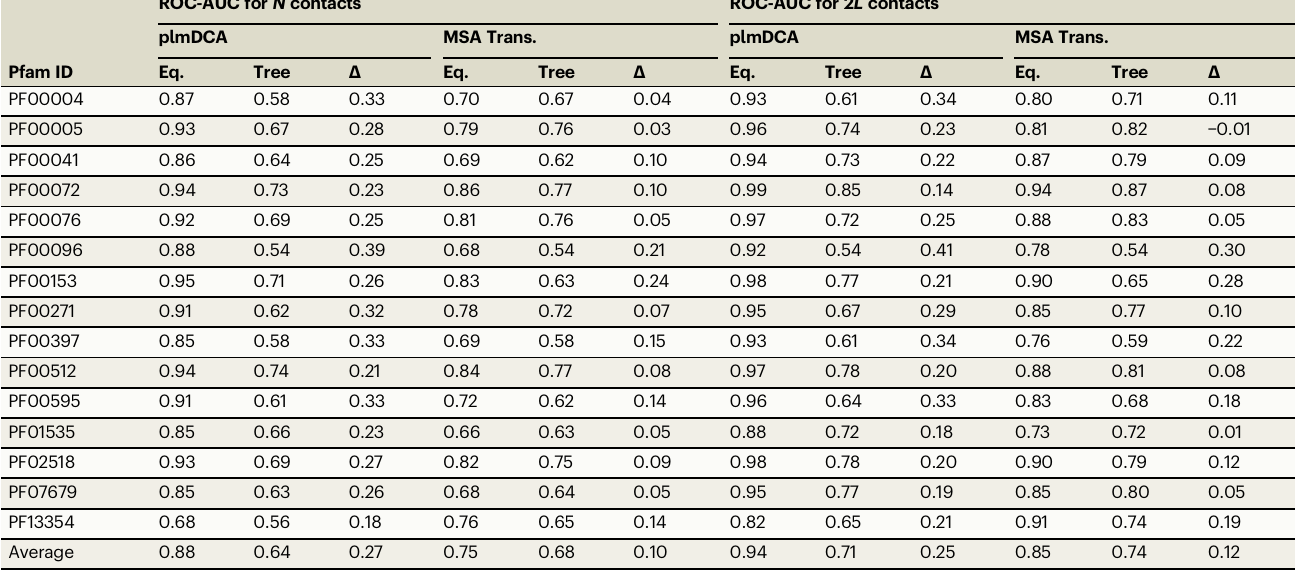
Table 2 | Impact of phylogeny on contact prediction by plmDCA and MSA Transformer ROC-AUC for N